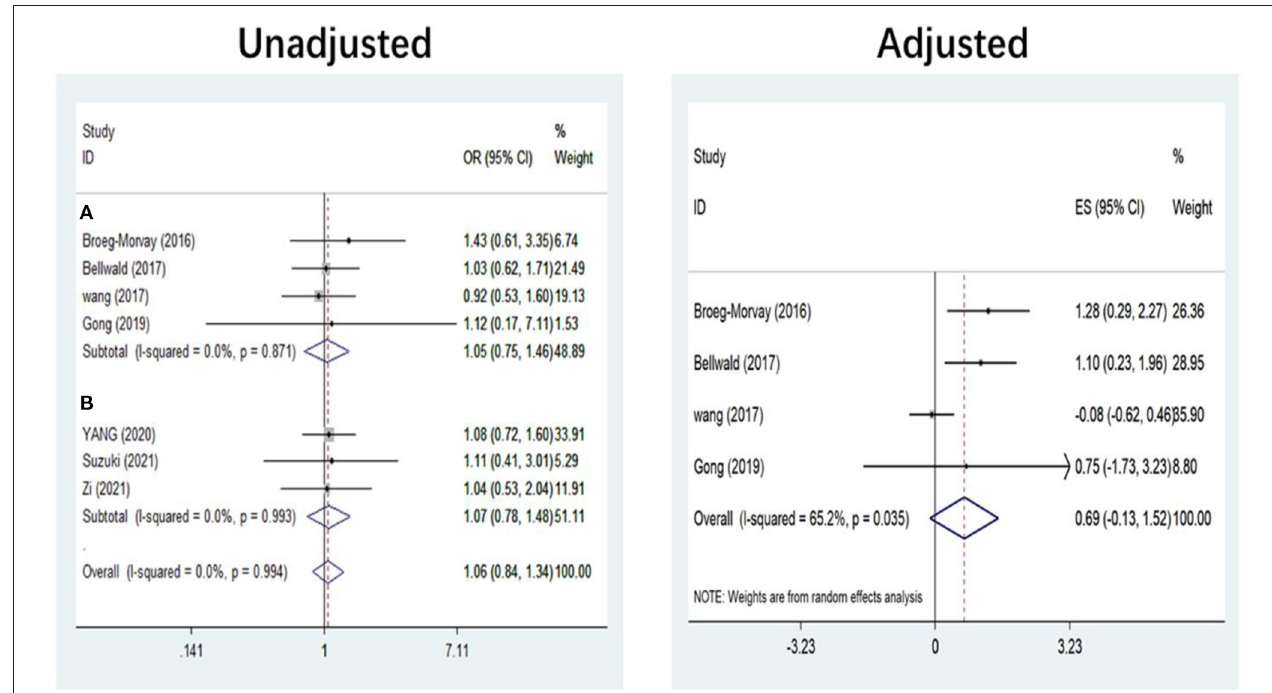
FIGURE 2 | Mortality at 90 days. (A) Non-RCT. (B) RCT. RCT , randomized controlled trial; ES , effect size.